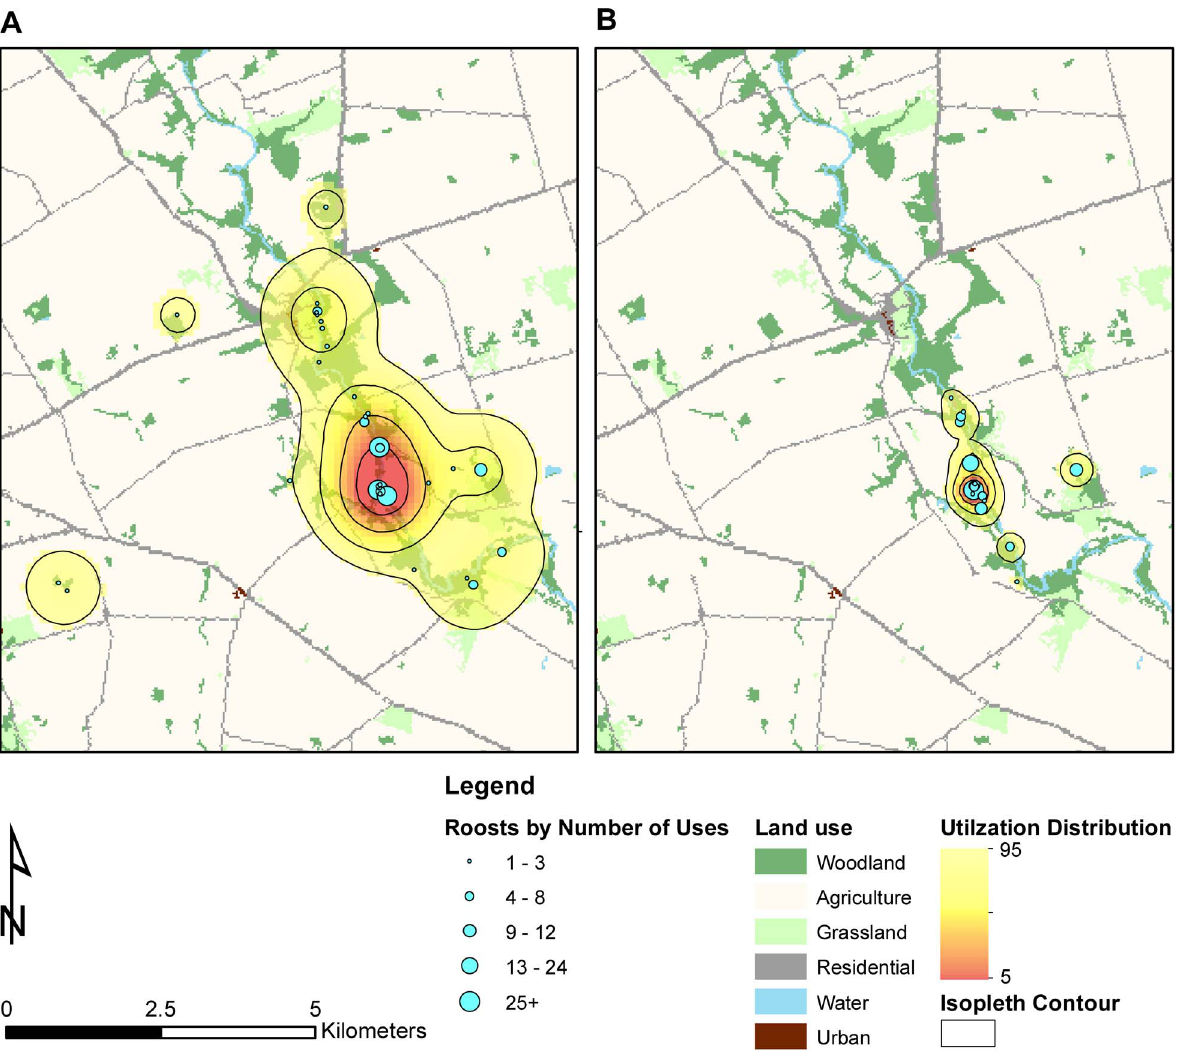
Figure 6. Indiana bat ( Myotissodalis ) roosting areas. Bivariate fixed kernel density roosting area utilization distributions and day-roost locations of an Indiana bat ( Myotis sodalis ) maternity colony in Pickaway County, Ohio, USA in 2009 (A) and 2010 (B). Estimation of the utilization distributions was conducted using the pooled locations from all radio-tagged bats and weighted by the number of uses of individual roosts. Roost size is log scaled by the number of uses to show the relative contribution to the utilization distribution. The 25, 50, 75, and 95% home range contour intervals are shown.